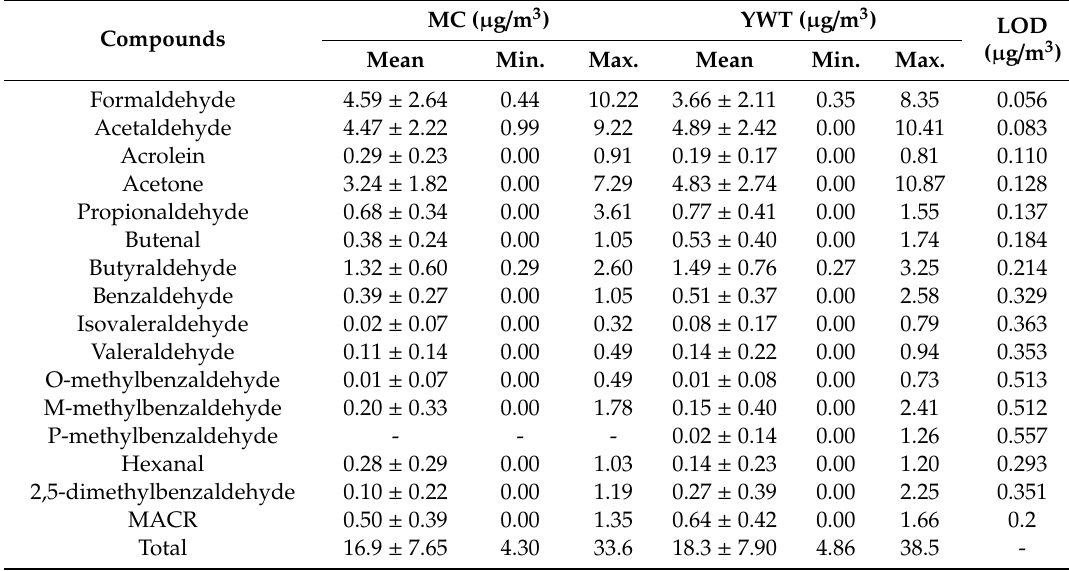
Table 1. Mean, min., and max. values and limit of detection (LOD) of atmospheric aldehyde and ketone compounds at Municipal Committee site (MC) and Yaowangtai site (YWT) from 16 to 25 January 2019.